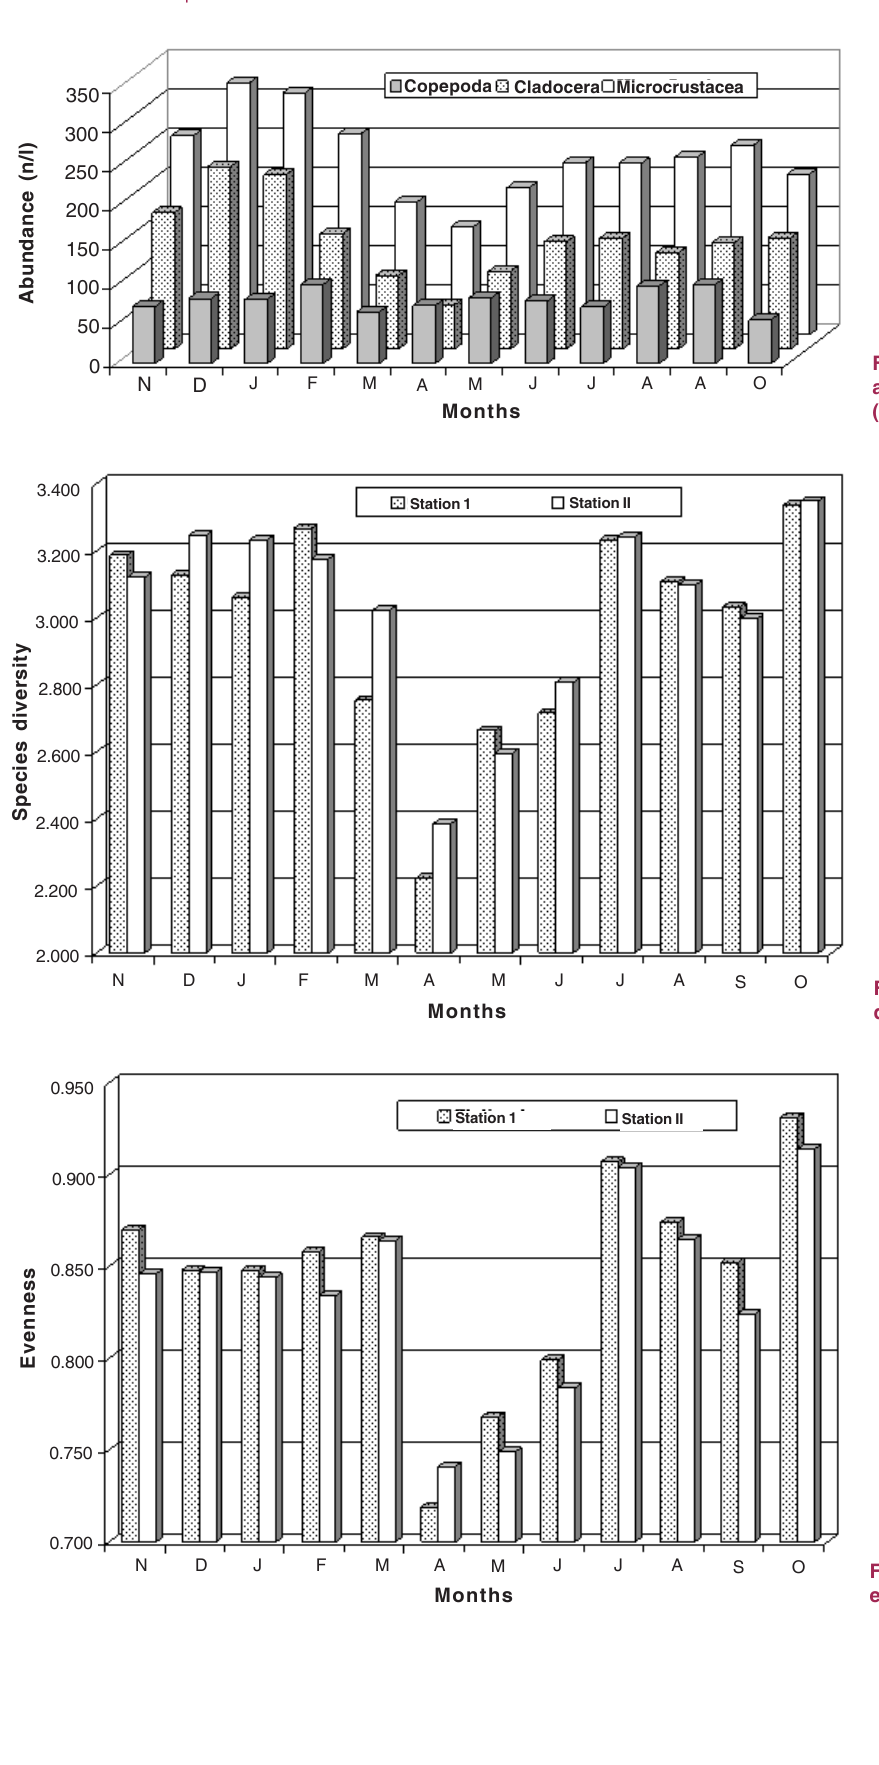
Figure 8. Monthly variations in evenness of